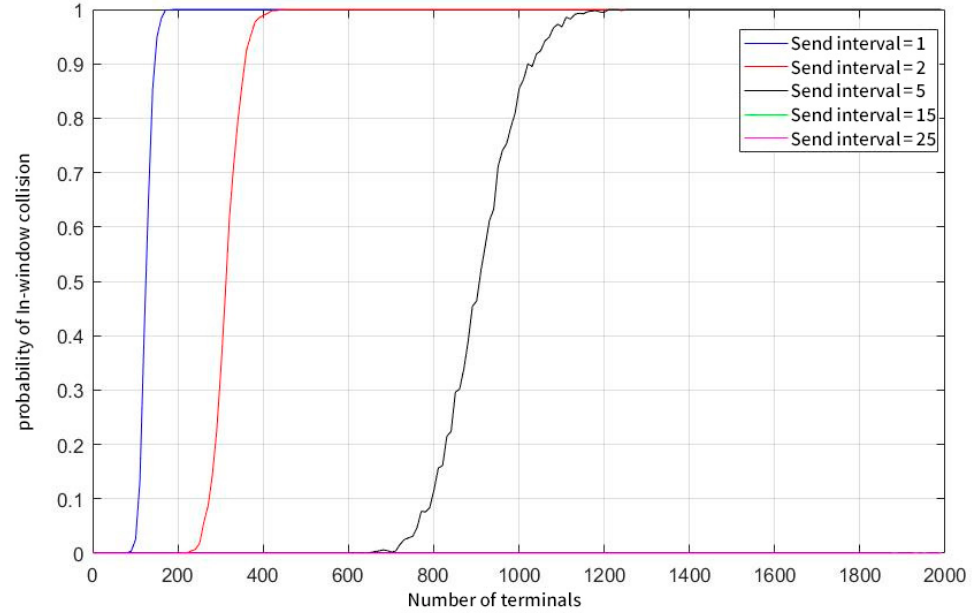
Figure 7. The probability of a window collision at concurrent demodulation thresholds equals 100.